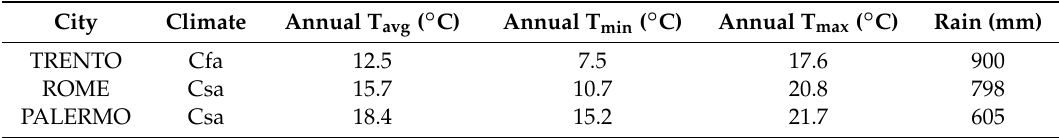
Table 2. Climate characteristics of the three locations selected for the study.